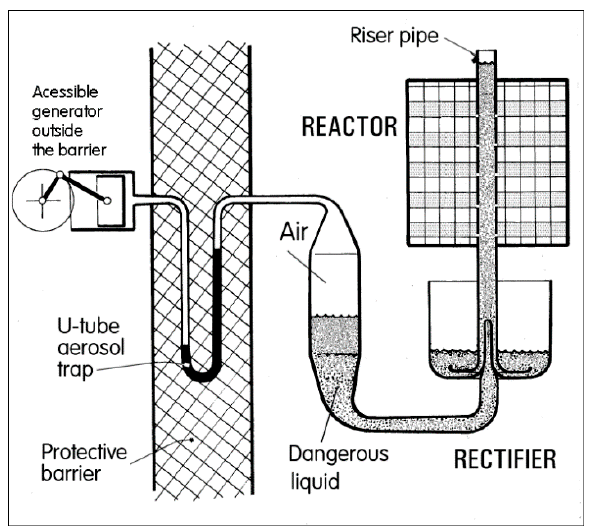
Figure 13. Application of the pressure generated by rectification of the alternating driving flow. In emergency situations, such as a coolant loss due to electricity failure, the liquid necessary for running the reaction leaves the reactor under gravity (picture from Patent document [3]). Energies 2019 , 12 , x FOR PEER REVIEW